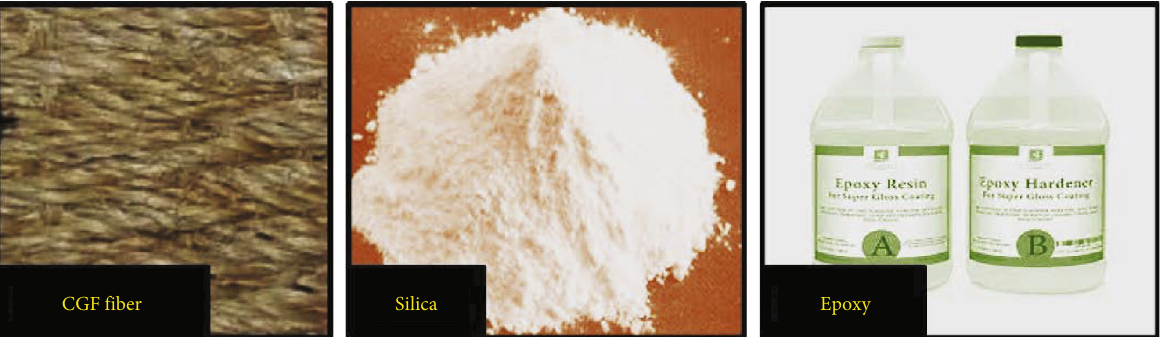
, and epoxy matrix. 2